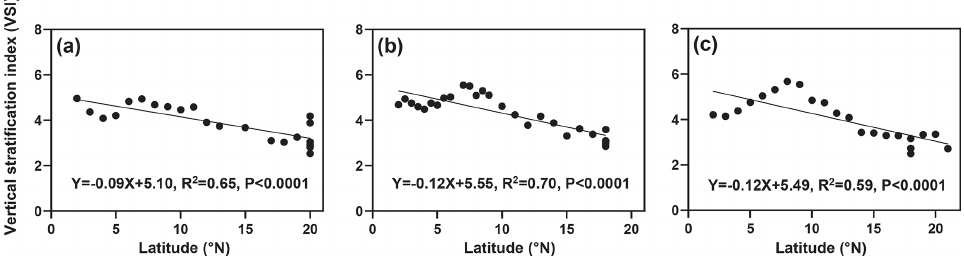
Figure 3. Linear fits of the vertical stratification index with latitude (a) in 2016, (b) 2017, and (c) 2018. The black dots are the VSI of each station.